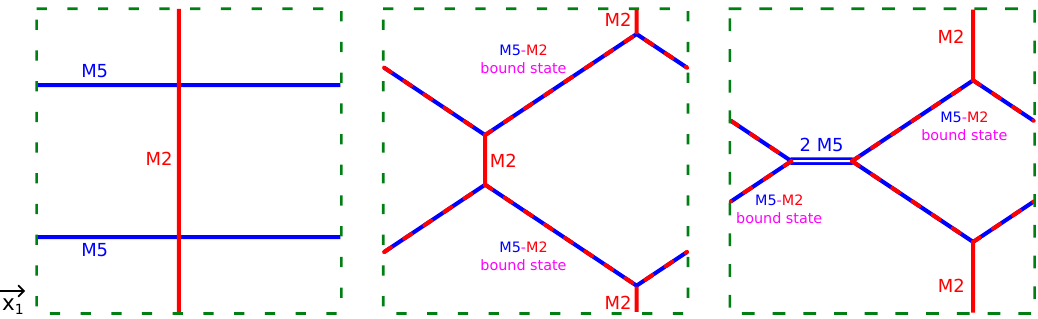
Figure 7 . A super-maze made of 2 M5 branes and a single M2 brane which is smeared along three of the M5 brane worldvolume directions. Before the fractionation the M2 brane does not pull on the M5 branes, and can be freely taken away. After the fractionation (middle panel), each strip of the M2 branes deforms the M5 brane in its vicinity. As the branes move, the web depicted in the middle panel can also transform in the web depicted in the right panel, which has regions of coincident un-fluxed M5